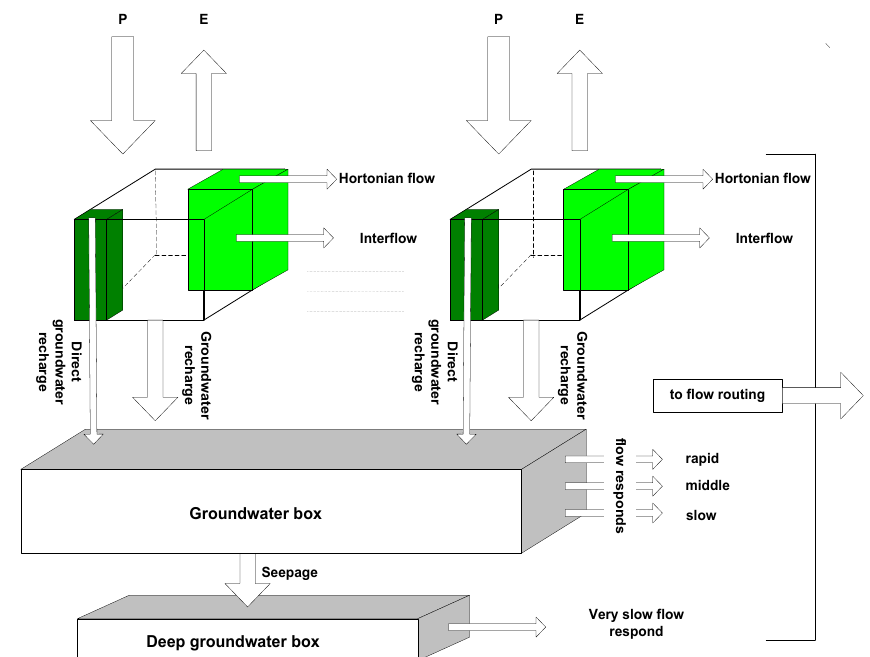
Figure 5. Structure of the Qbox rainfall–runoff model (source: Iritz,